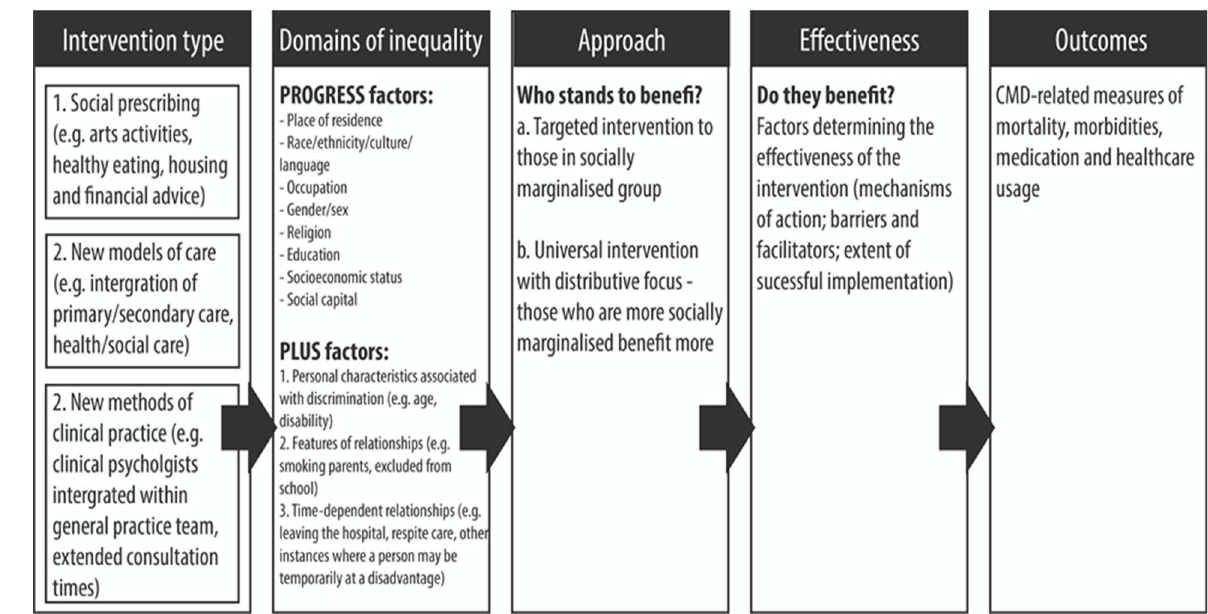
Figure 1. Framework for addressing inequalities in CMD-related health outcomes in relation to the PROGRESS-Plus domains [17,43,44], adapted from Sowden et al. [41].